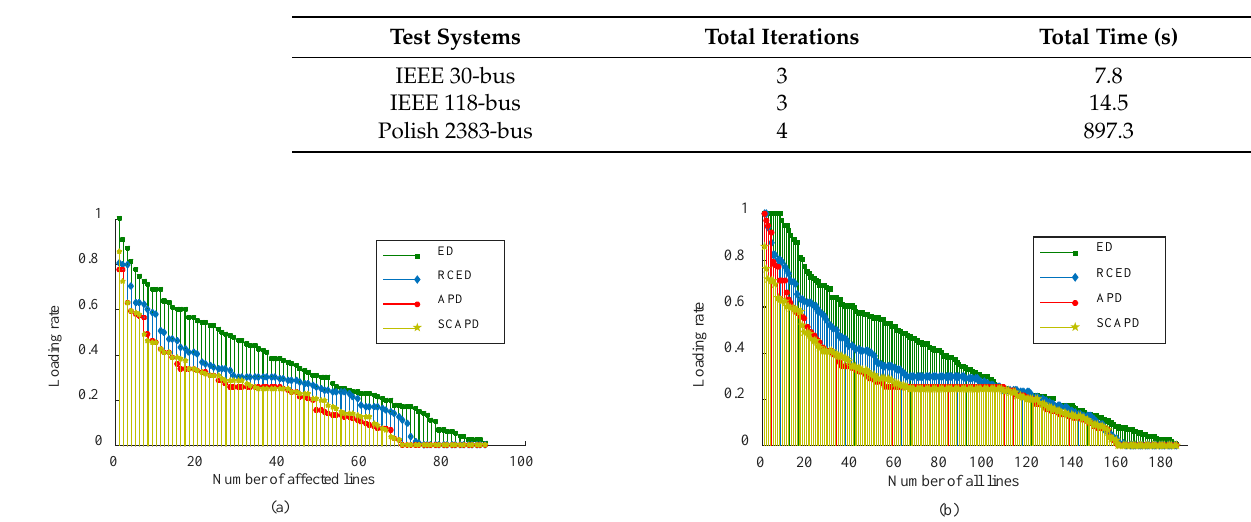
Table 6. Total iterations and computation time for solving SCAPD in different test systems.